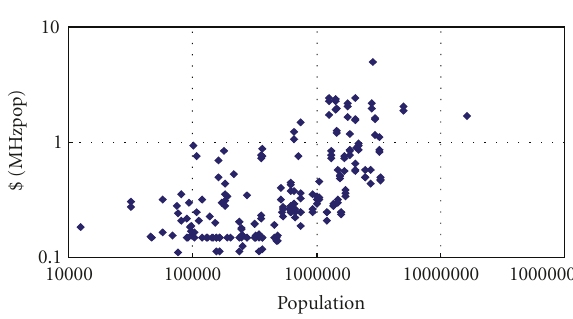
Figure 3: Normalized spectrum cost as a function of population for full BTAs auctioned in the PCS broadband